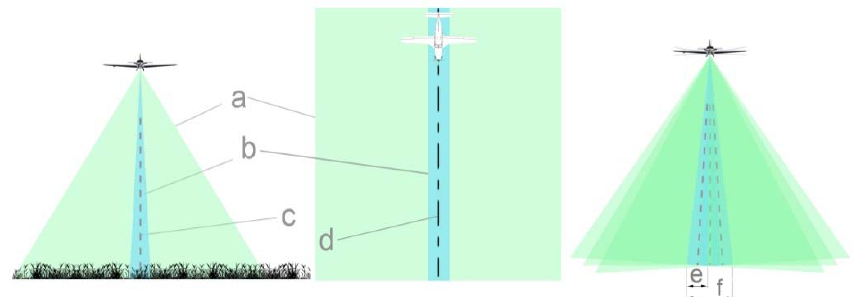
Figure 2. The preliminary low-resolution aerial survey’s 54.43 ◦ horizontal angle of view ( a ) and swath width ratio, the high spatial resolution aerial survey’s vertical axis aerial camera’s 4.1 ◦ horizontal angle of view ( b ) and swath width ratio, the camera axis ( c ), and the swath centerline ( d ). It’s important to prevent rotation of the rolling shaft, especially in the case of the high-resolution survey, because of the displacement distance ( f ) and swath width ( e ) ratio.